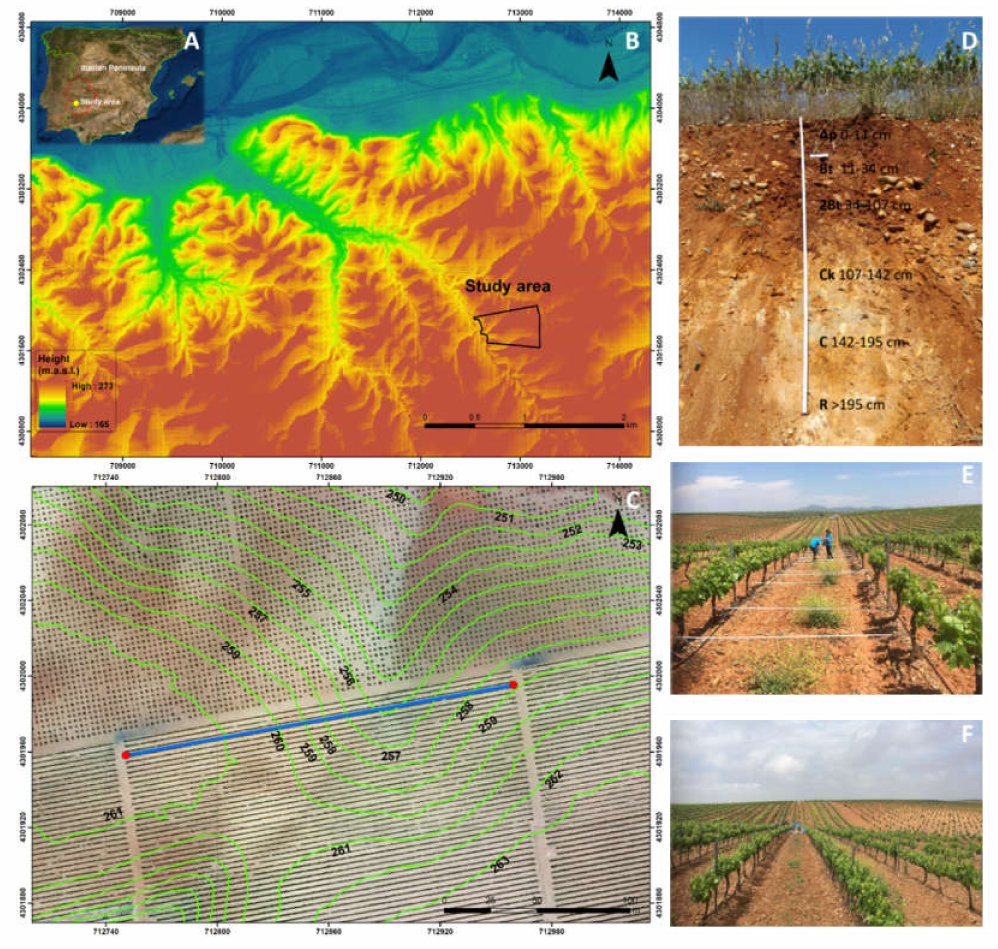
Figure 1. ( A ) Location of the study area; ( B ) and ( C ) topography; ( D ) soil profile; and ( E ) and ( F ) general view of the rows and inter-row areas in May